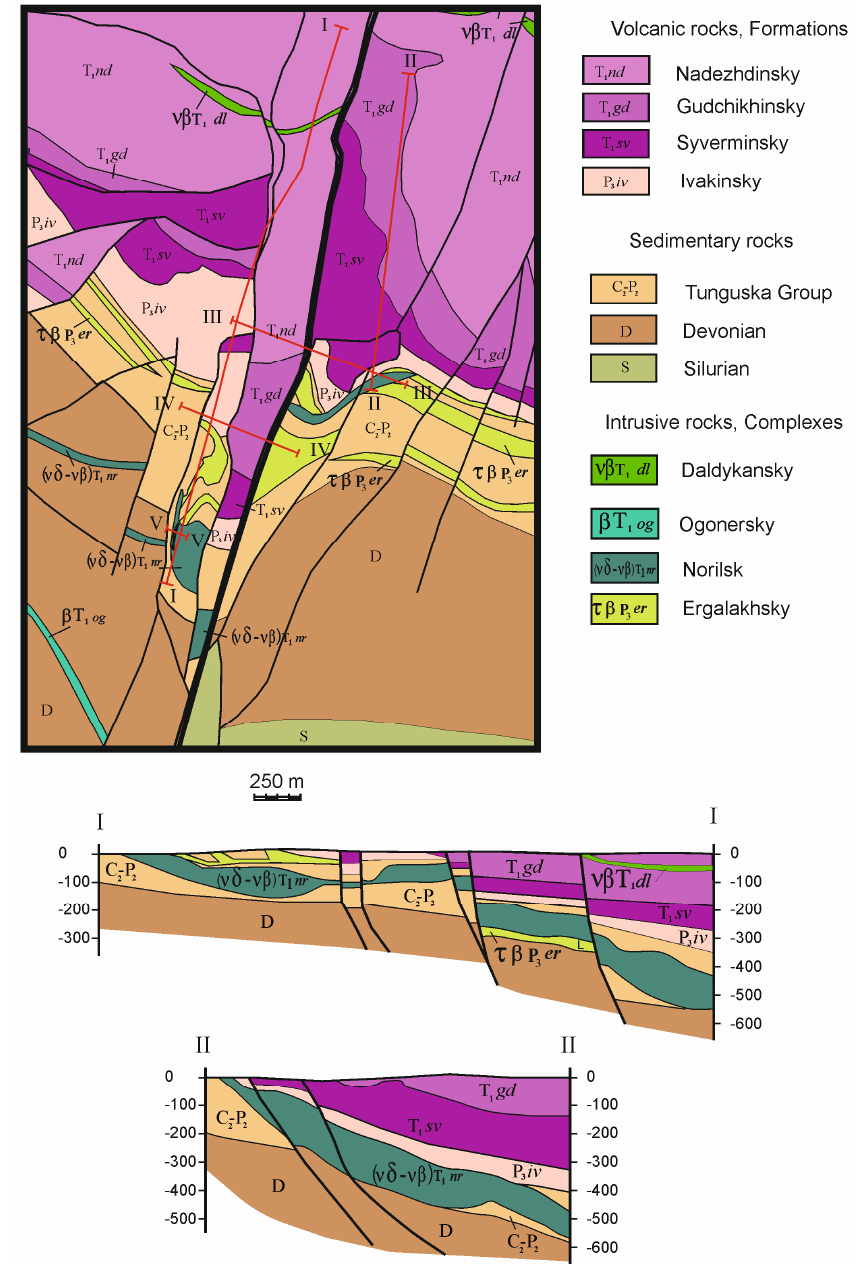
Figure 3. Geological map of the Talnakh ore junction and cross-sections I-I and II-II (here and in Figure 4 based on data of Ltd. Norilskgeologia with author’s corrections) with the longitude sections. The red lines on the map are line of cross section and their numbers.